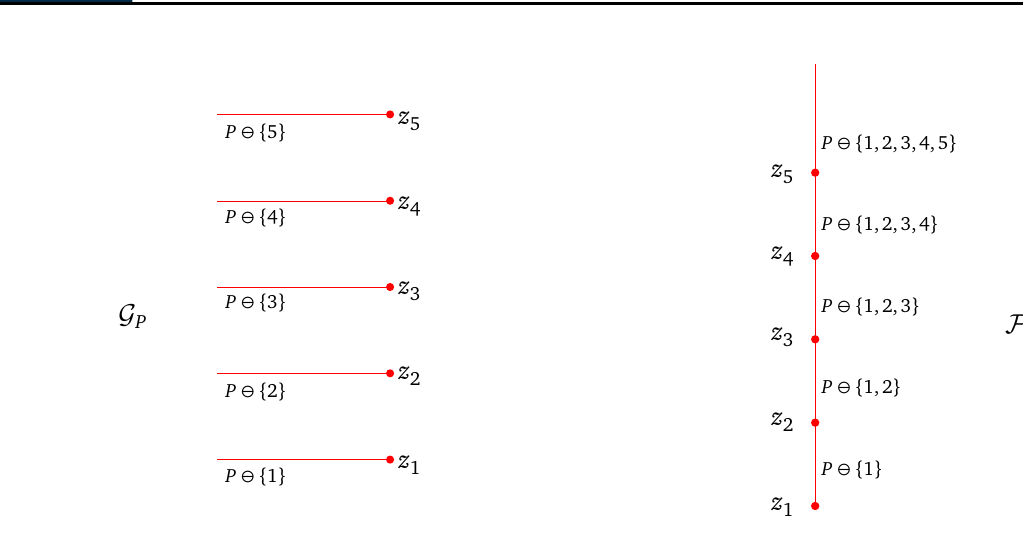
Figure 5: Two different choices of branch cuts (solid lines) for the function f (cid:59) defined in (28) with N = 5. The branch points are represented by dots. The sets labelling the sheet reached after crossing branch cuts from either side starting from the sheet labelled by P ⊂ { 1,2,3,4,5 } is indicated near the branch